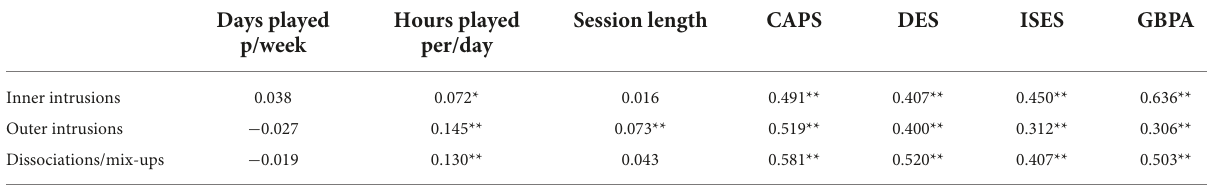
TABLE 8 Correlation between GTP dimensions, playing habits (Criterium validity) and general involuntary phenomena, and associative phenomena with game content (Convergent validity). Days played